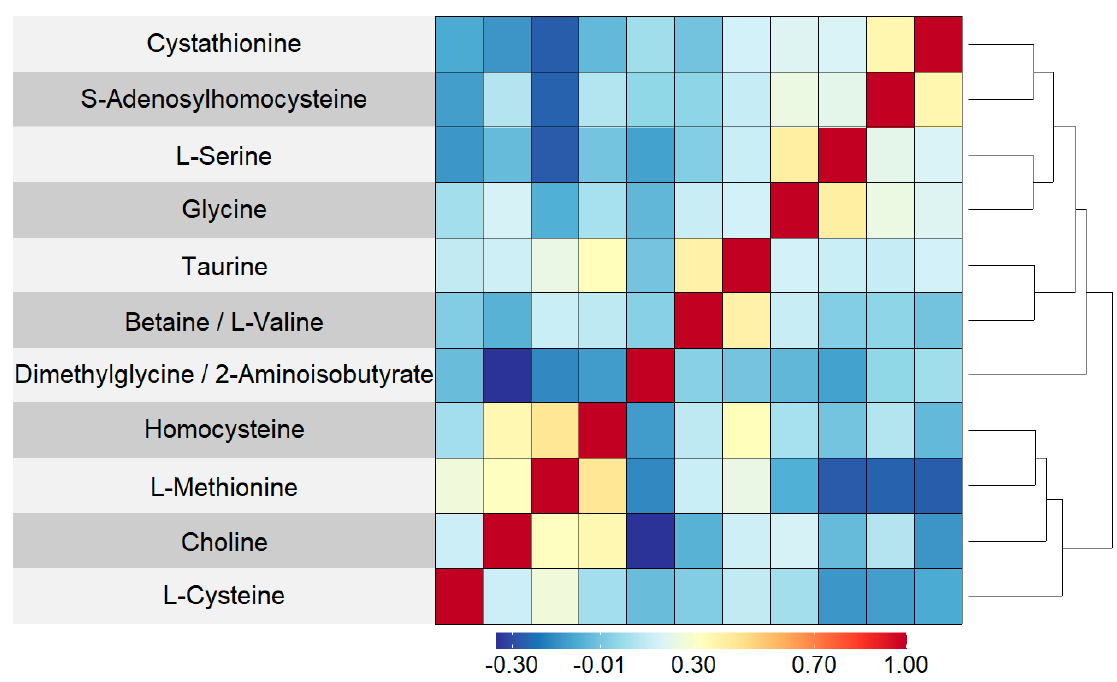
Figure 3. Pseudo-color image of Spearman correlation matrix for 11 folate pathway features, with rows and columns ordered by complete linkage hierarchical clustering. A darker red indicated a stronger positive correlation and a darker blue indicated a stronger negative correlation. As it is a symmetric matrix, the columns correspond to the same set and ordering of metabolites as the rows.